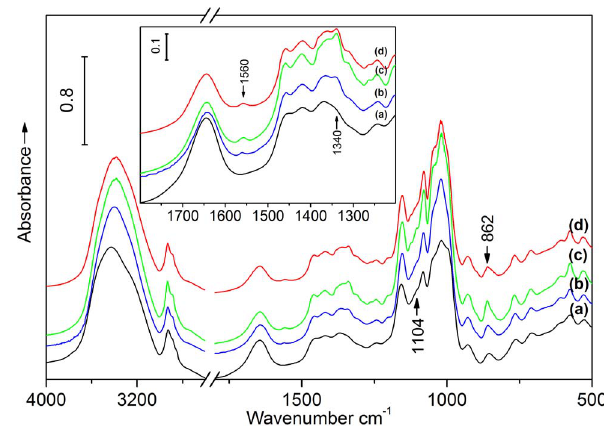
Figure 4. FT-IR spectra of (a) WMS, (b) SNC H2SO4,3 , (c) SNC